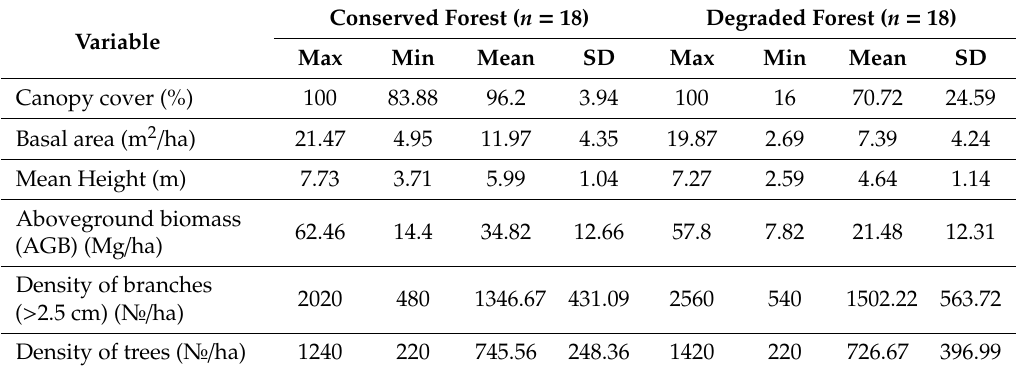
Table 1. Summary of forest structural parameters in conserved and degraded forest